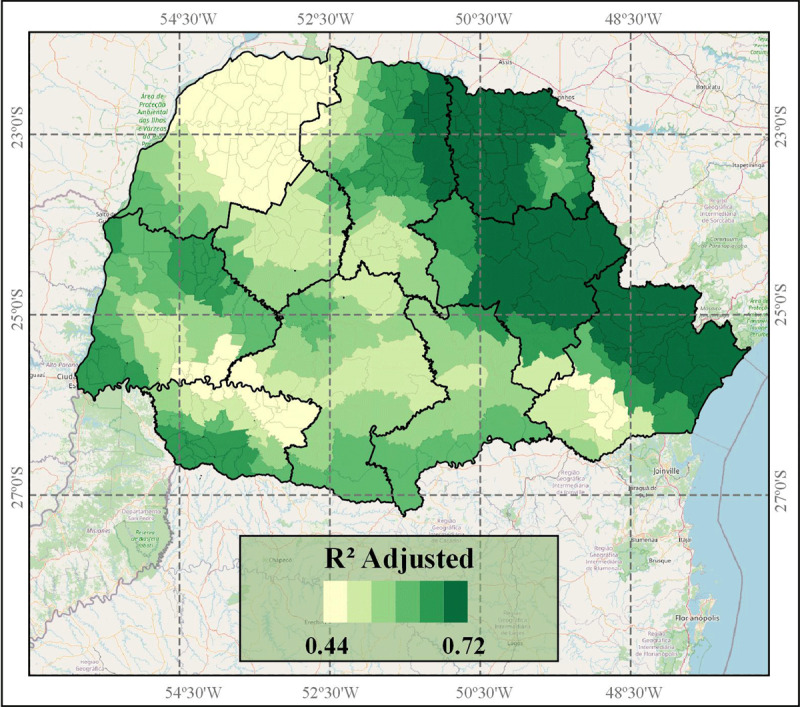
Spatial distribution of local GWR adjusted R2 values according to each Parana State municipality, located in mesoregions.